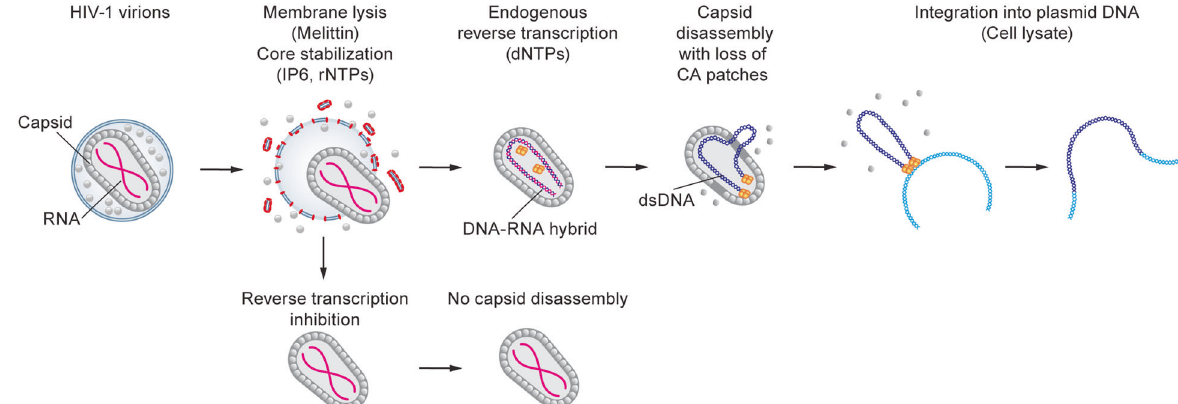
Fig. 1 HIV-1 virions are lysed gently with melittin in the presence of IP6 and rNTPs to stabilize the viral cores. The addition of dNTPs initiates endogenous reverse transcription (ERT), which fi rst copies viral RNA to form minus-strand DNA, and subsequently copies the minus-strand DNA to form double-stranded DNA (dsDNA). The dsDNA, which is rigid compared to genomic RNA or single-stranded DNA, creates internal pressure and initiates capsid disassembly, with localized loss of capsid (CA) patches. The viral dsDNA can integrate into a target plasmid DNA, which requires capsid disassembly and the addition of cell lysate. When reverse transcription is inhibited, very few disassembled capsids are observed, indicating that reverse transcription is required for capsid